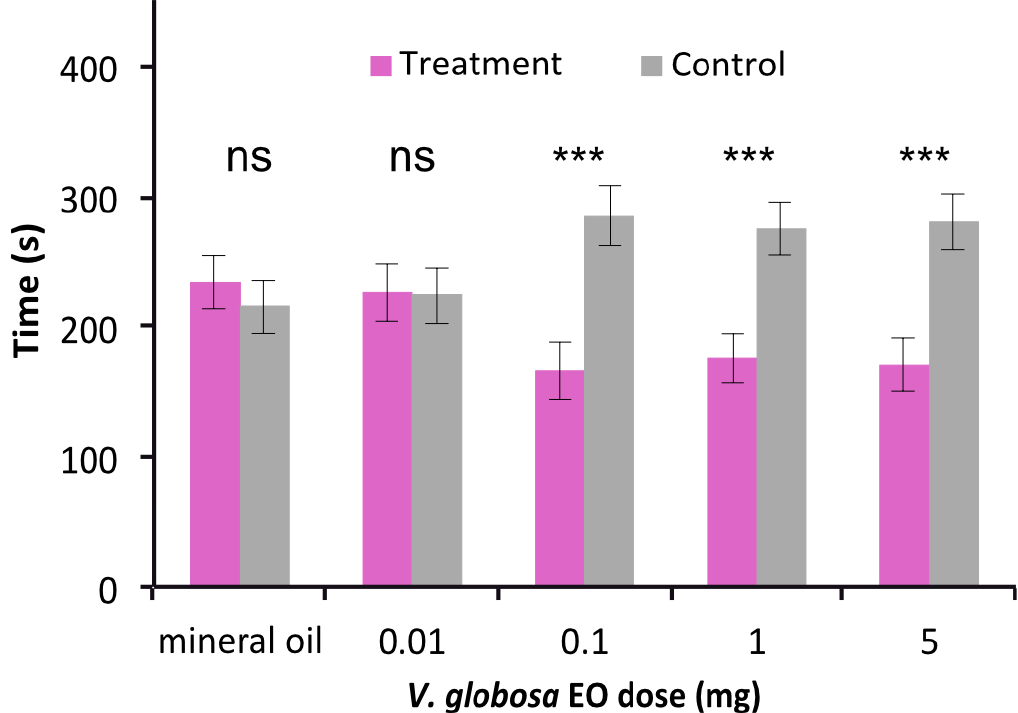
Figure 1. Behavioural effect of V. globosa essential oil at different doses in choice experiments against a control (mineral oil) (means, SE). Doses of at least 0.1 mg are repulsive to T. confusum . n = 29–32; ns not significant, *** p ≤ 0.001.